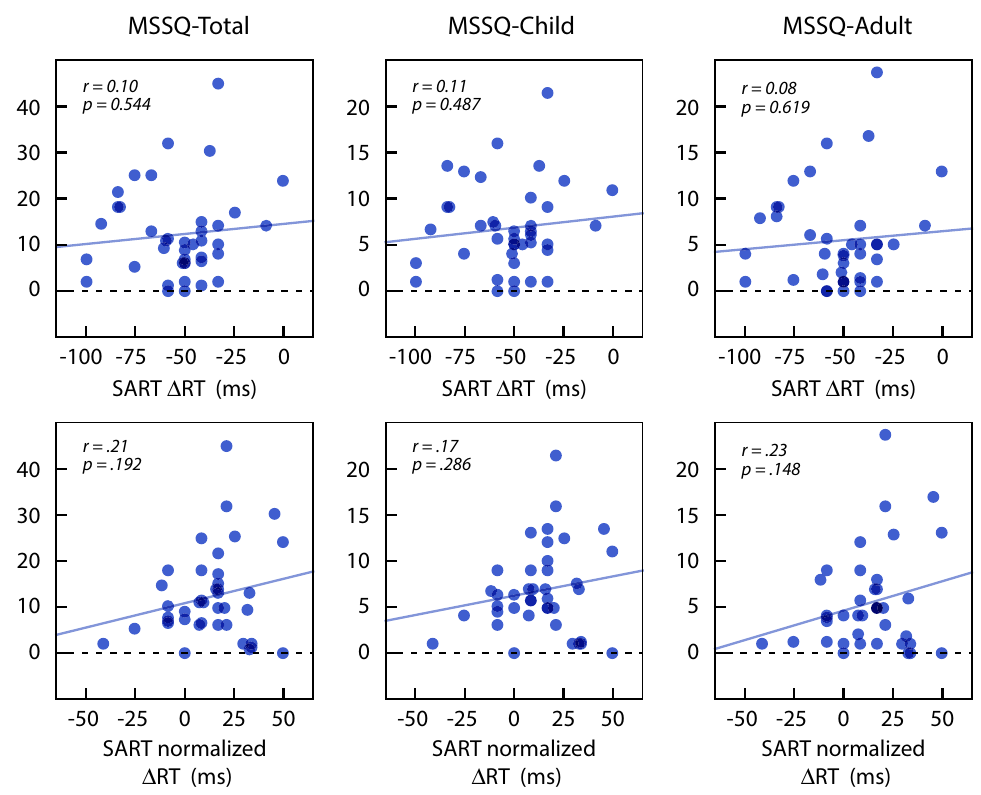
Fig. 10 Self-reported motion sickness susceptibility (MSSQ) of individual subjects in Experiment 2 plotted as a function of their attentional allocation scores derived from SART. The two rows use different measures of attentional allocation: the mean difference in reaction times for central and peripheral targets with coherent background motion (top row), or the mean difference after normalizing for reaction times in the incoherent motion conditions (bottom row). Positive values of ΔRT correspond to more attention to the periphery. Lines show the regression fits. The left graph plots the total MSSQ scores, and the middle and right graphs plot the MSSQ child and MSSQ adult